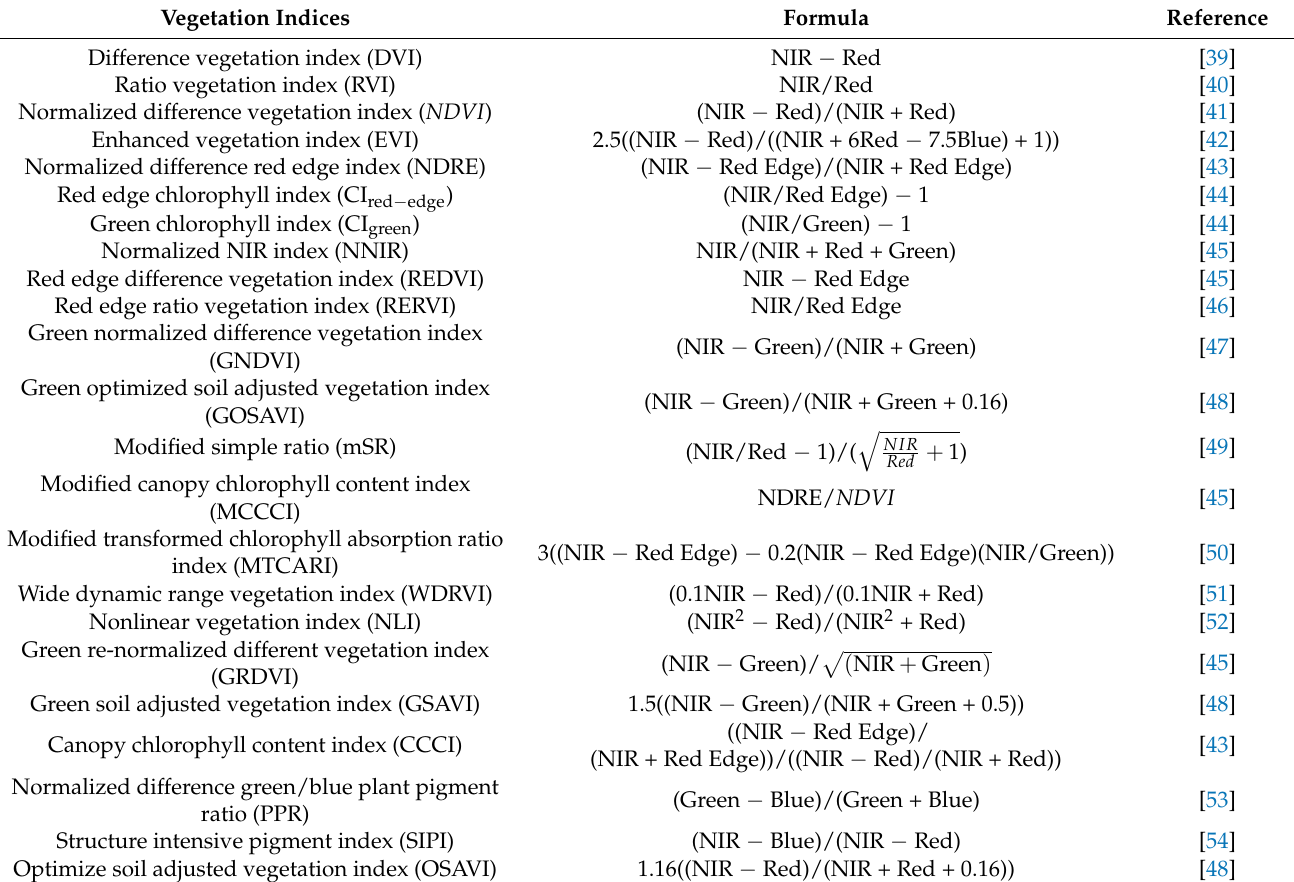
Table 4. The list of the vegetation indices used in this